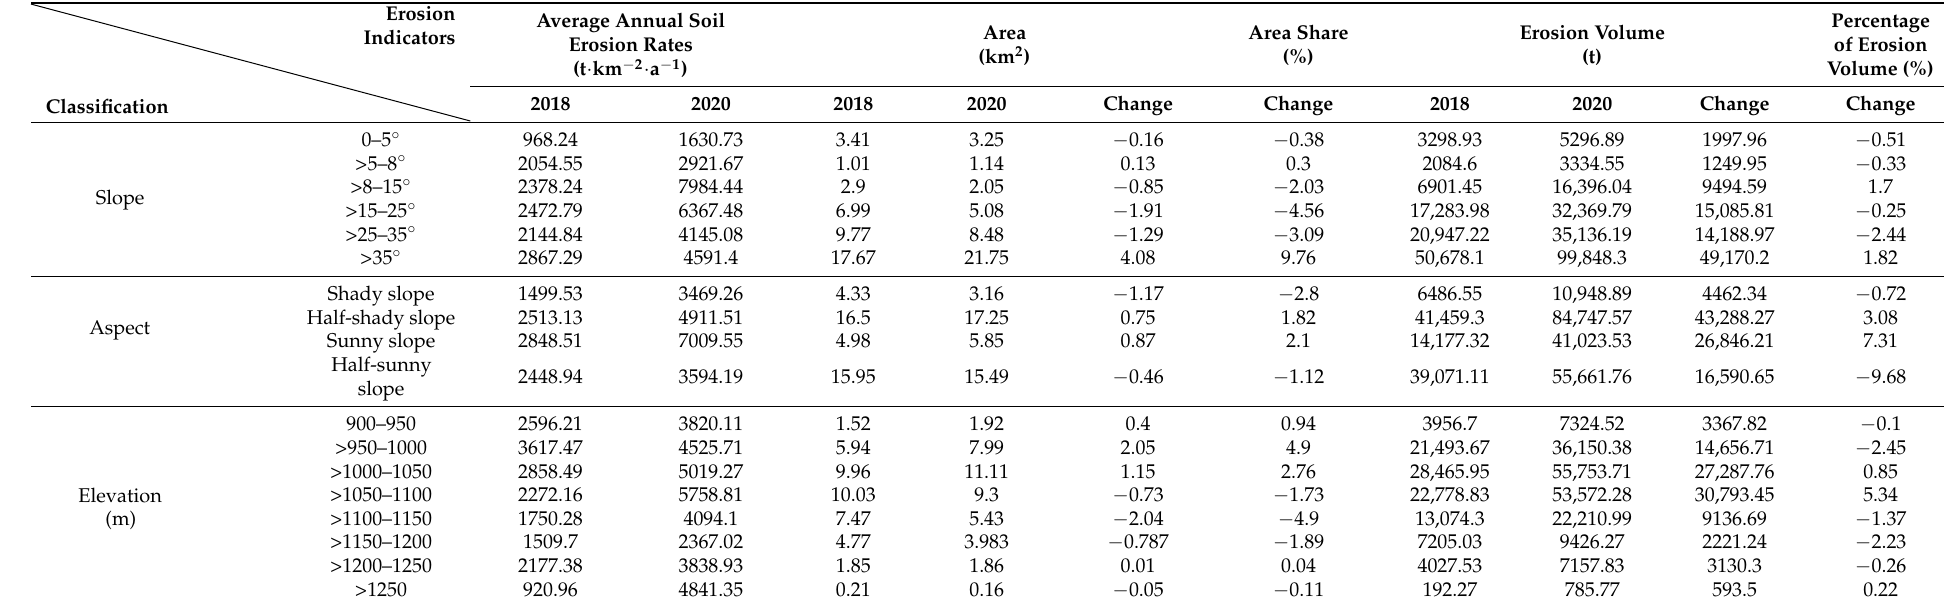
Table 4. Statistical table of soil erosion under different